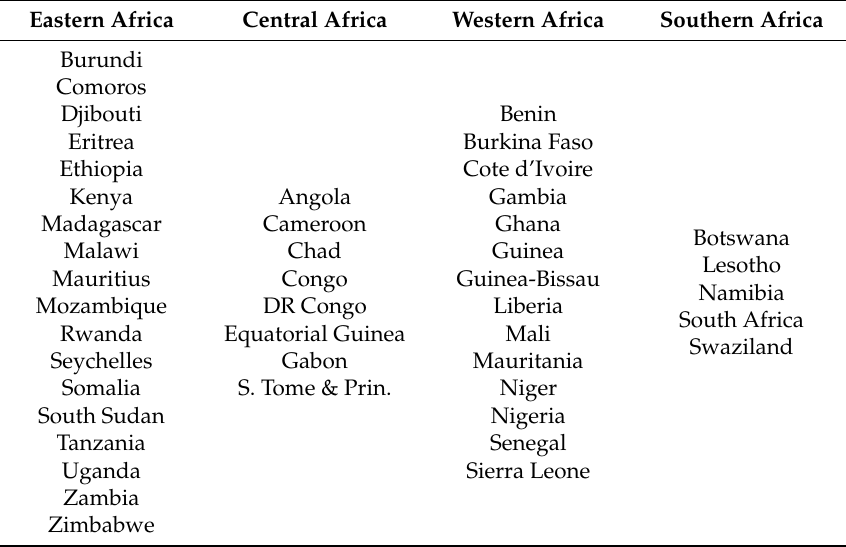
Table A1. Regions of